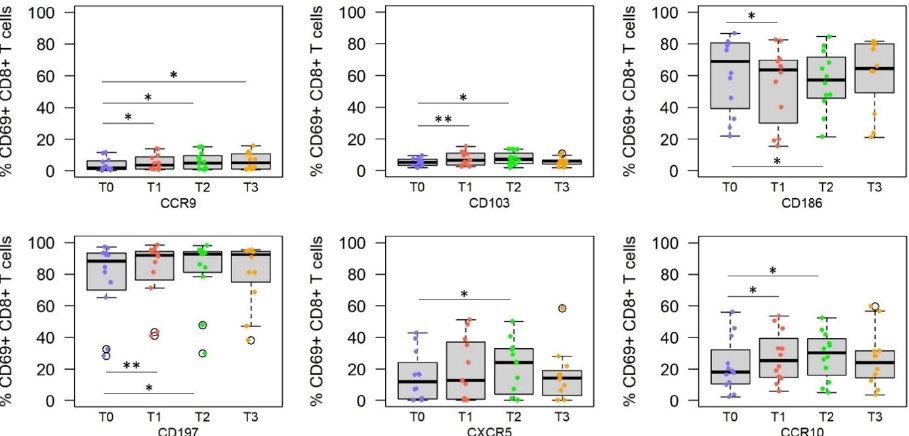
Figure 3. Homing receptor profile of SPZ-specific CD8 + T cells at different time points after vaccination and CHMI. Statistical analysis revealed that the frequency of CD69 + CD8 + T cells expressing CCR9 (top left), CD103 (top middle), CD186 (top right), CD197 (bottom left), CXCR5 (bottom middle), and CCR10 (bottom right) was significantly altered when testing at different time points (T0 = pre-immune, T1 = 2 weeks after the third immunization, T2 = 5–6 days after CHMI, T3 = 3–4 months after CHMI). Asterisk indicates statistical significance (* p < 0.05, ** p <